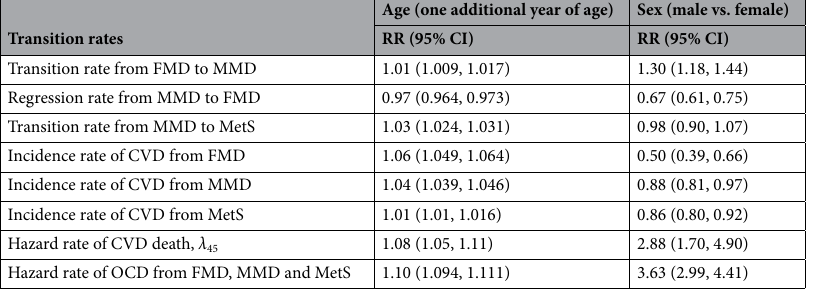
Table 4. Effects of age and sex on multi-state progression associated with metabolic scoring status and